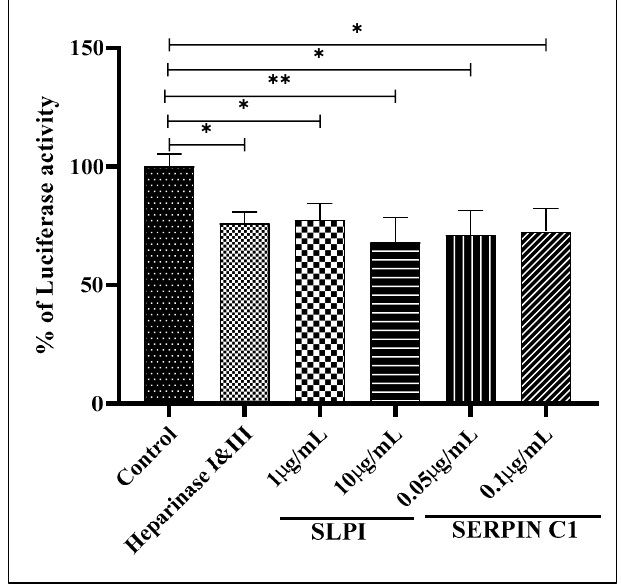
Figure 7. In Trans HIV-1 transmission Assay; HeLa cells (0.05 × 10 6 cells/well in a 24-well plate) were incubated for 2 h at 37 °C with SLPI (1 μ g/mL and 10 μ g/mL) or SERPIN C1 (with 0.05 μ g/mL and 0.1 μ g/mL). Heparinase I and III (20 IU/mL) was used as a negative control. HIV-1 BaL (10 ng of p24) was added to HeLa cells target cells for 1 h at 37 °C in a final volume of 100 μ L of serum free DMEM to facilitate virus adsorption. Cells were washed five times with 100 μ L of PBS to remove unbound material and overlaid with TZM-bl indicator cells (0.05 × 10 6 cells/well). After sixty hours post infection productive HIV-1infection and replication was quantitated using the Luciferase Assay System. Results are expressed as mean ± SEM from three independent experiments. Asterisk (*) over the bars indicates significant difference with control, ** p < 0.001 and * p ≤ 0.05. p -values were generated by one-way ANOVA with multiple comparisons.